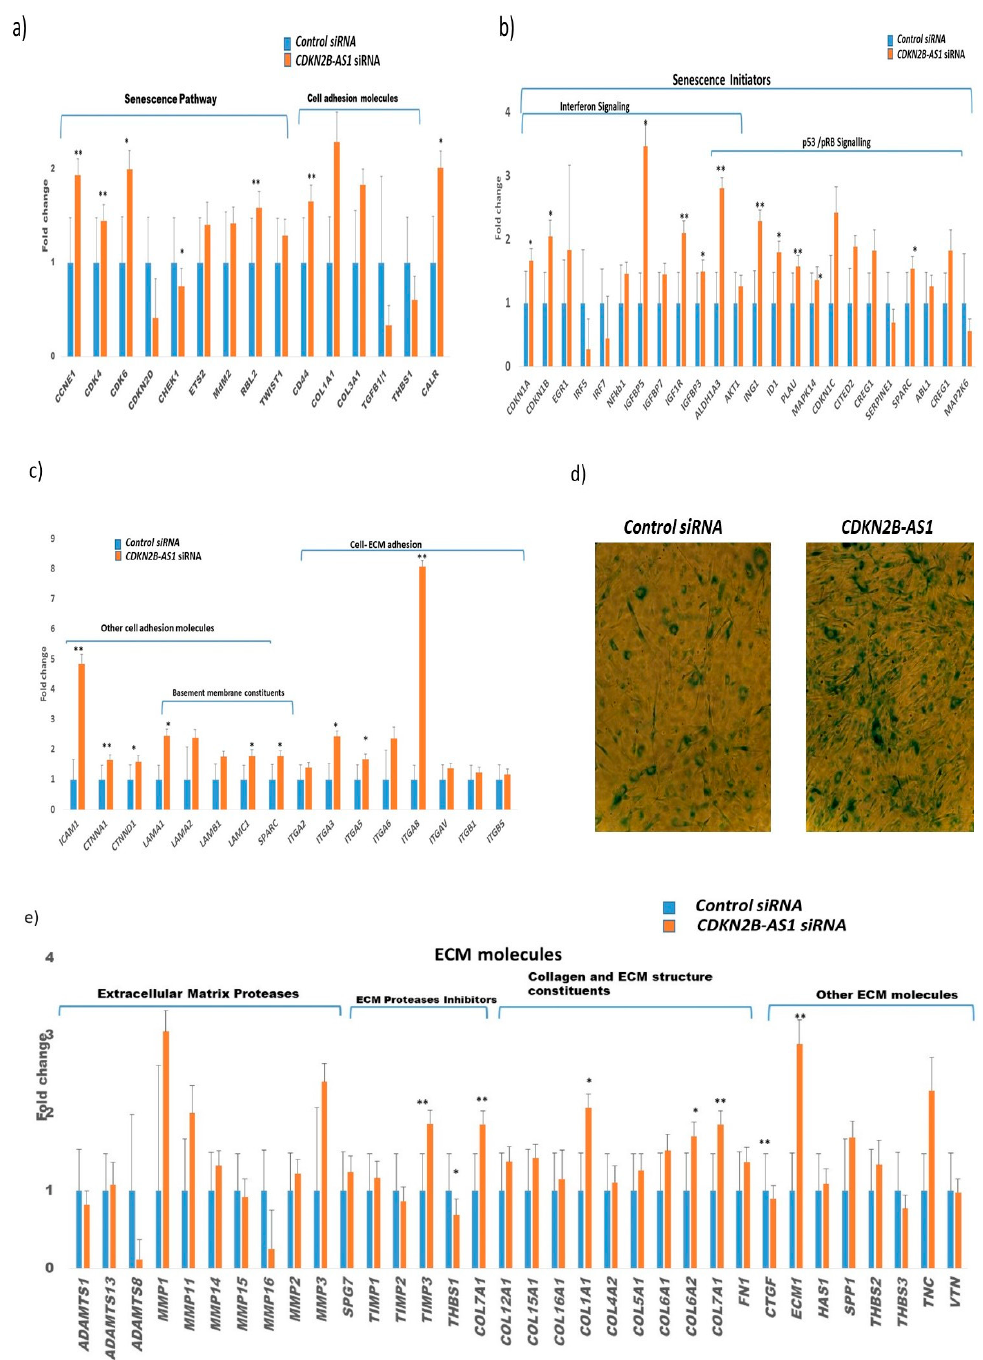
Figure 4. Cellular senescence in TM cells after suppression of CDKN2B-AS1 . ( a – c , e ) The human cellular senescence and extracellular matrix and adhesion molecules RT 2 Profiler PCR arrays showed differential gene expression profile in TM cells after 10 nM CDKN2B-AS1 siRNA and control siRNA treatment for 72 h. Bar graphs illustrate fold change (2 −ΔΔ C T ) ± SEM. Asterisks indicate significance of difference from controls ** p < 0.05, * p < 0.005, ( d ) Senescence-related β -galactosidase staining of TM cells after 10 nM CDKN2B-AS1 siRNA and control siRNA treatment. Blue color stained cells are β -galactosidase positive cells indicates senescence. Magnification 10 ×